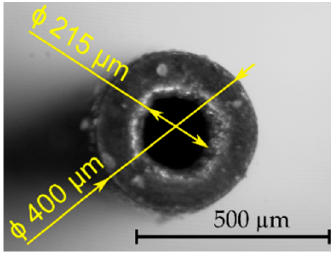
Figure 1. Thermophysical properties of Inconel 718 superalloy according to the increase in temperature T : ( a ) heat capacity; ( b ) thermal conductivity; ( c ) density [8].